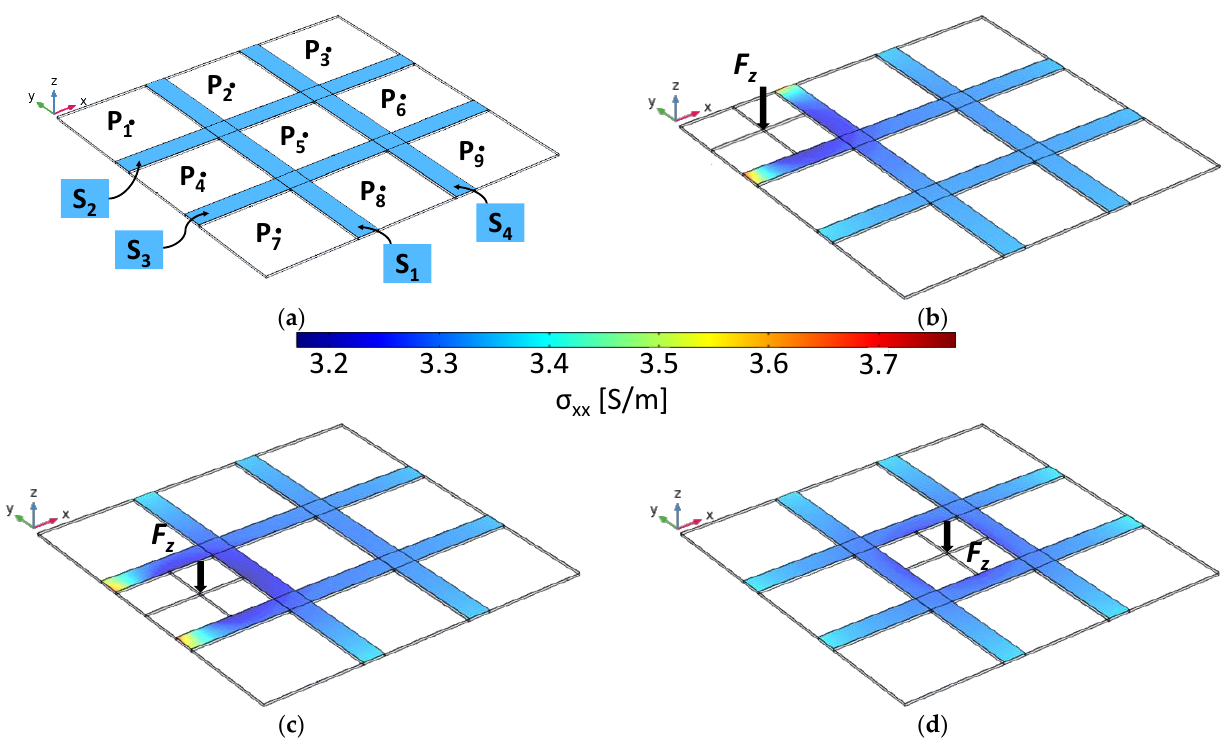
Figure 20. ( a ) Schematic representation of the surface subdivision map. Conductivity maps of the piezoresistive strips at the maximum induced plate deformation of the sensors as a function of the load applied on the zones: P1 ( b ), P4 ( c ), and P5 ( d ). Table 2. Simulated resistance variation of the four sensors, depending on the force application point.